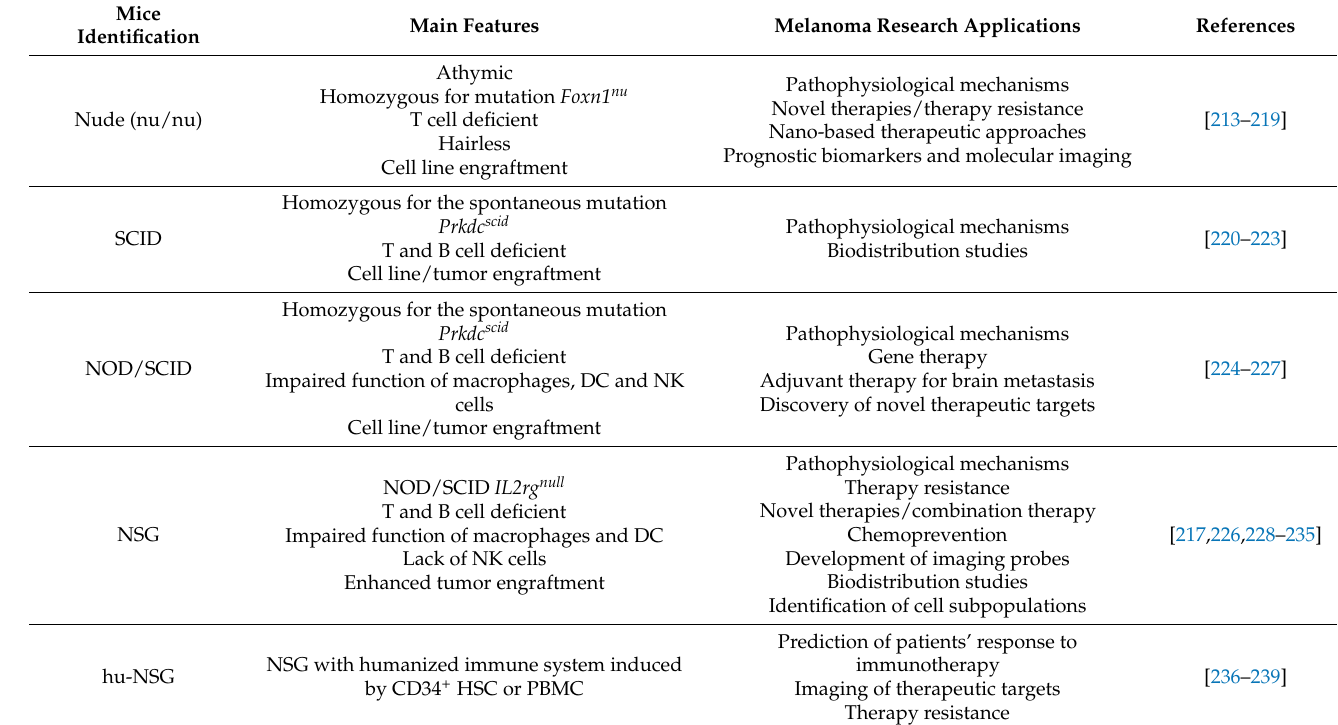
Table 4. Most frequently used immunocompromised mice for melanoma